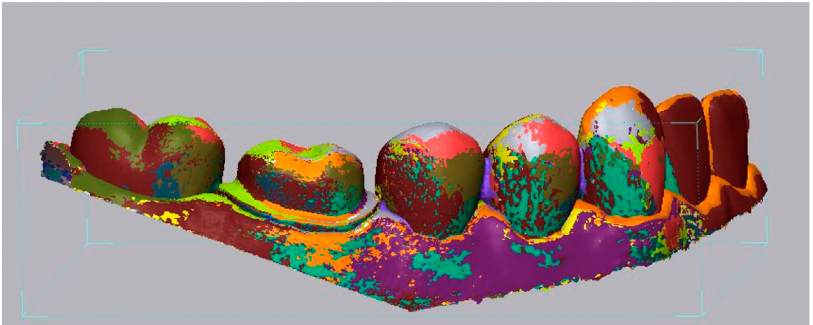
Figure 2. Superimposition of a master scan obtained from the 3Shape D2000 desktop scanner and intraoral scans from the 3Shape TRIOS 3 scanner using the Geomagic Control X software. The images were aligned using both the Initial Alignment and Best-Fit Alignment functions. The colors depict overlays of multiple scans.